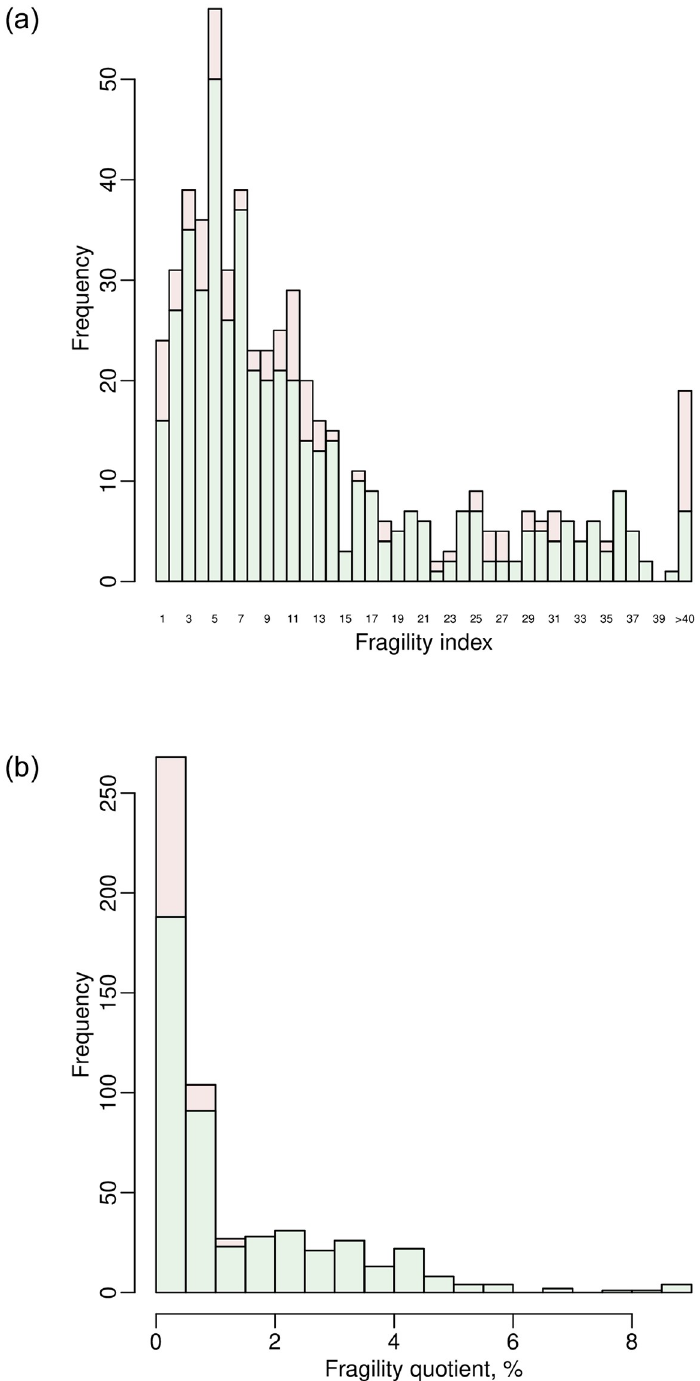
Fig 12. Distributions of fragility measures of the pairwise meta-analyses in the dataset dat.ns . (a) Bar plot of fragility indexes. (b) Histogram of fragility quotients.